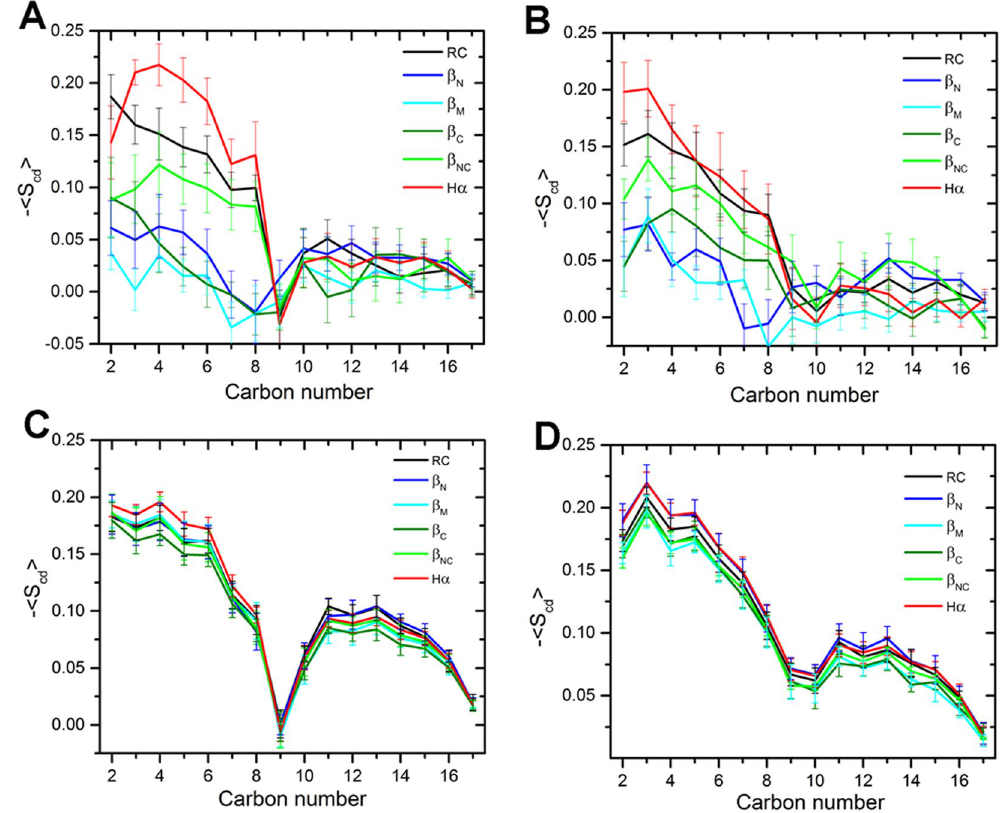
Figure 6. Order parameter - < S cd > for the acyl chains of DOPC lipids binding to different intermediates as a function of carbon atom index. ( A ) sn -1 and ( B ) sn -2 chain of the DOPC within 15 Å of the proteins. ( C ) sn -1 and ( D ) sn -2 chain of DOPC whose distances to proteins are larger than 15 Å. The angle brackets denote the average values over the last 100 ns simulation time, the error bars corresponding to the deviations of five 20-ns windows in the last 100 ns trajectories.